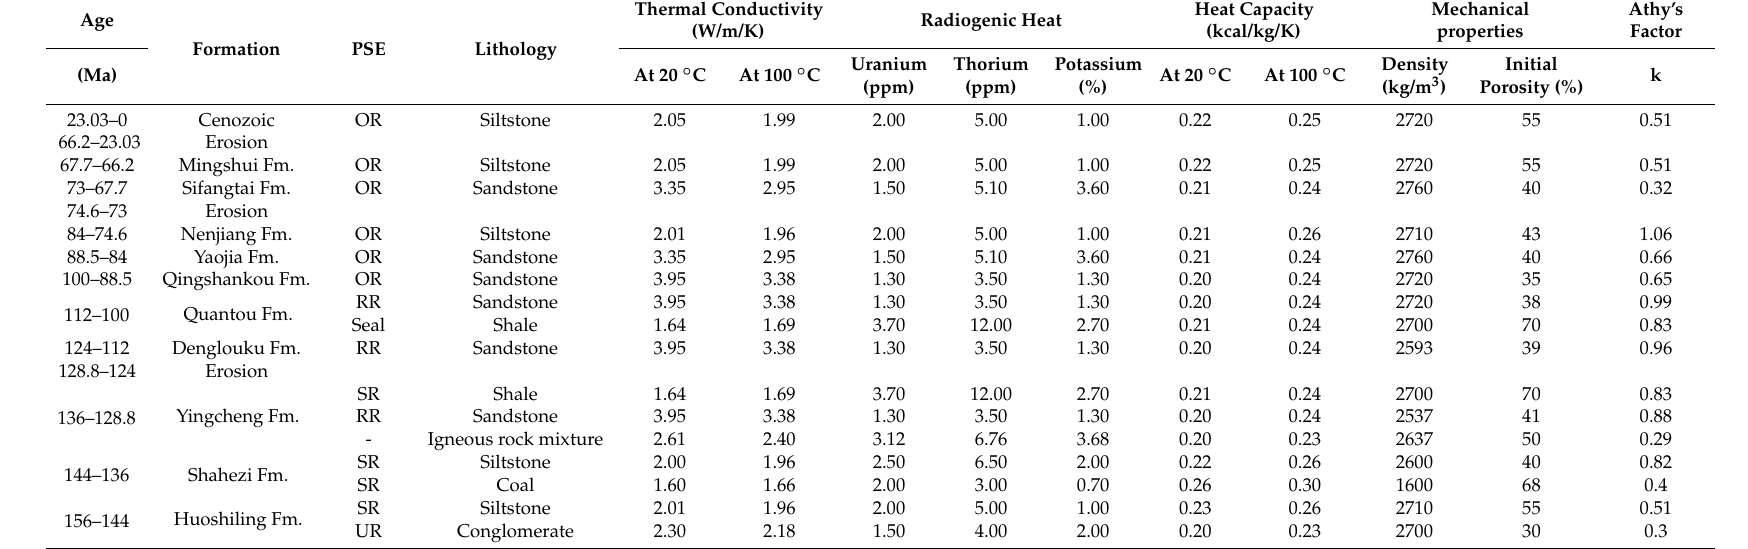
Table 1. Facies settings for PetroMod ® software, including ages, formations, PSE, lithology settings with thermal parameters and mechanical properties. The Athy’s factors are discussed in Section